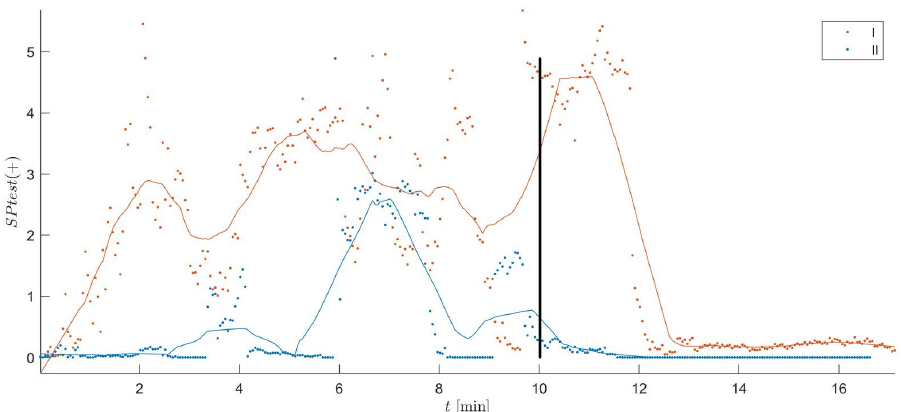
Figure 3. MATLAB trends showing the development of vasoconstriction in the thigh and calf coincident with the area of the patient’s daily complaint. Legend: MATLAB trends presenting the development of the percentage size of amplified vasoconstriction in the thigh and calf defined as autonomic referred pain (AURP) and including the condition of a Δ ₸ ° decrease ≥ 0.3 °C. The SP test resulted in: (I) 271 out of 320 measured thermograms (84.7%) from 3 ′ 41 ″